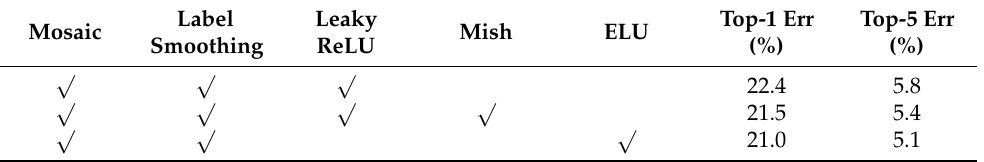
Table 1. Comparison table of activation functions under the COCO dataset.